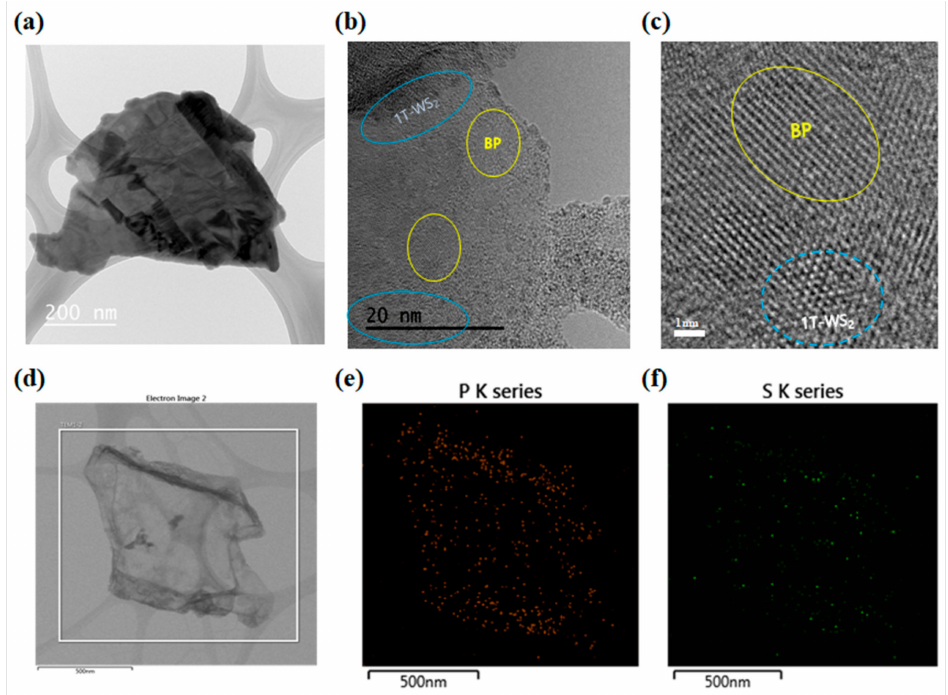
Figure 3. HR-TEM data of OBP/1T-WS 2 nanocomposite at various magnifications ( a – c ) HAADF- STEM image ( d ), and EDX elemental mapping of ( e ) P and ( f ) S.